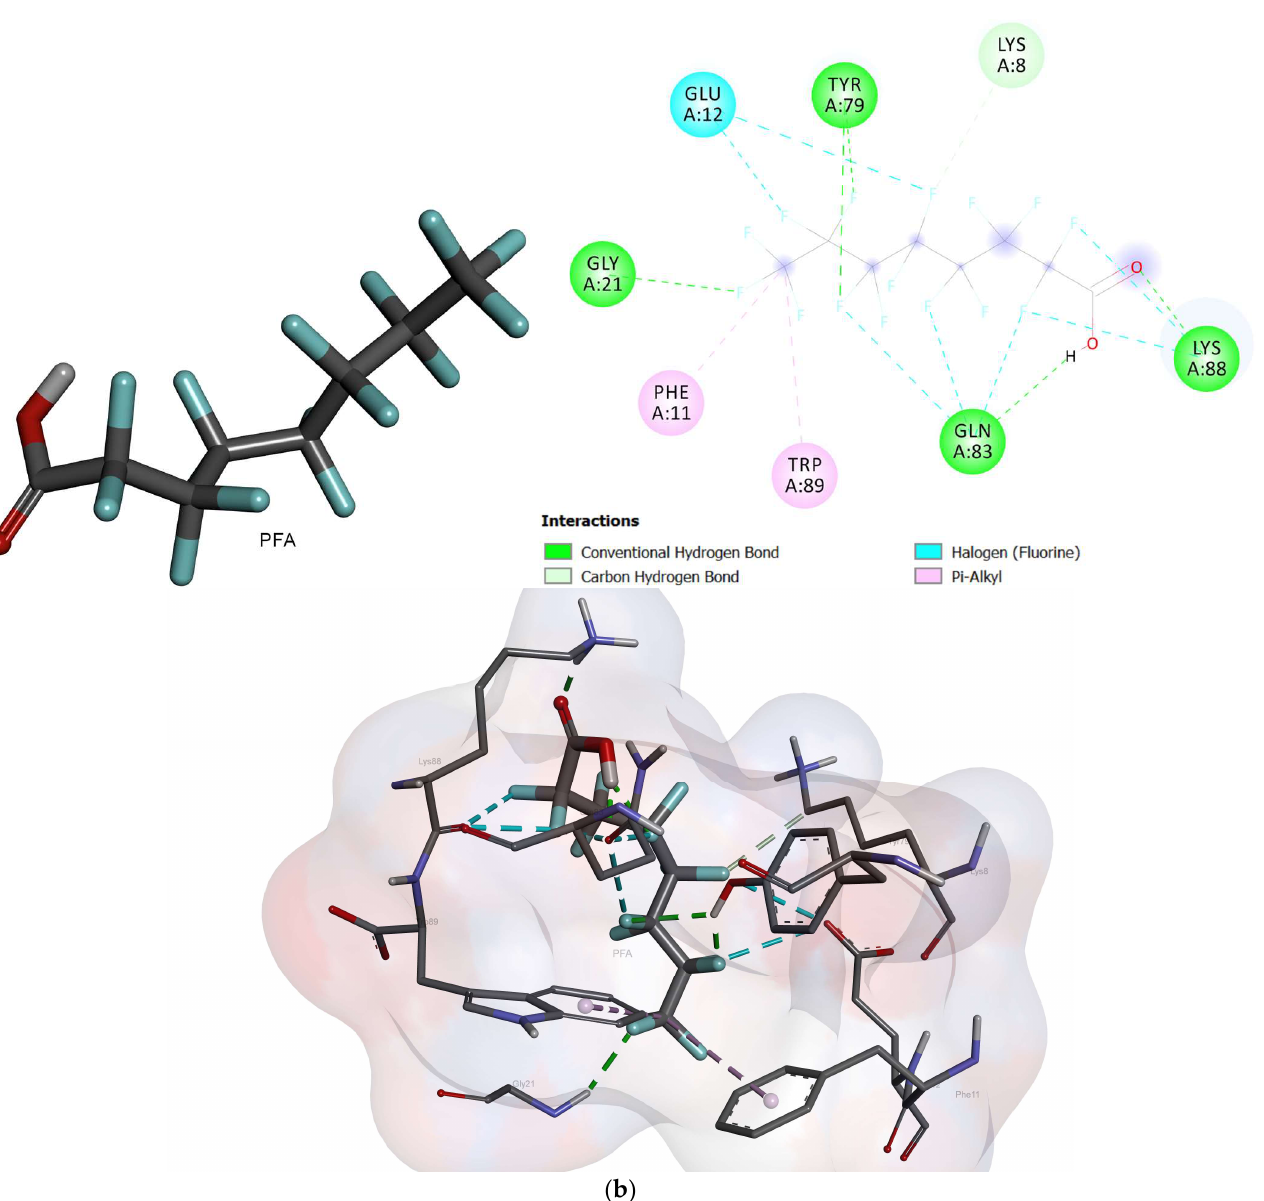
Figure 4. The interactions between oxidized cytochrome c6 and ligands; ( a ) PFOS and ( b ) PFOA.